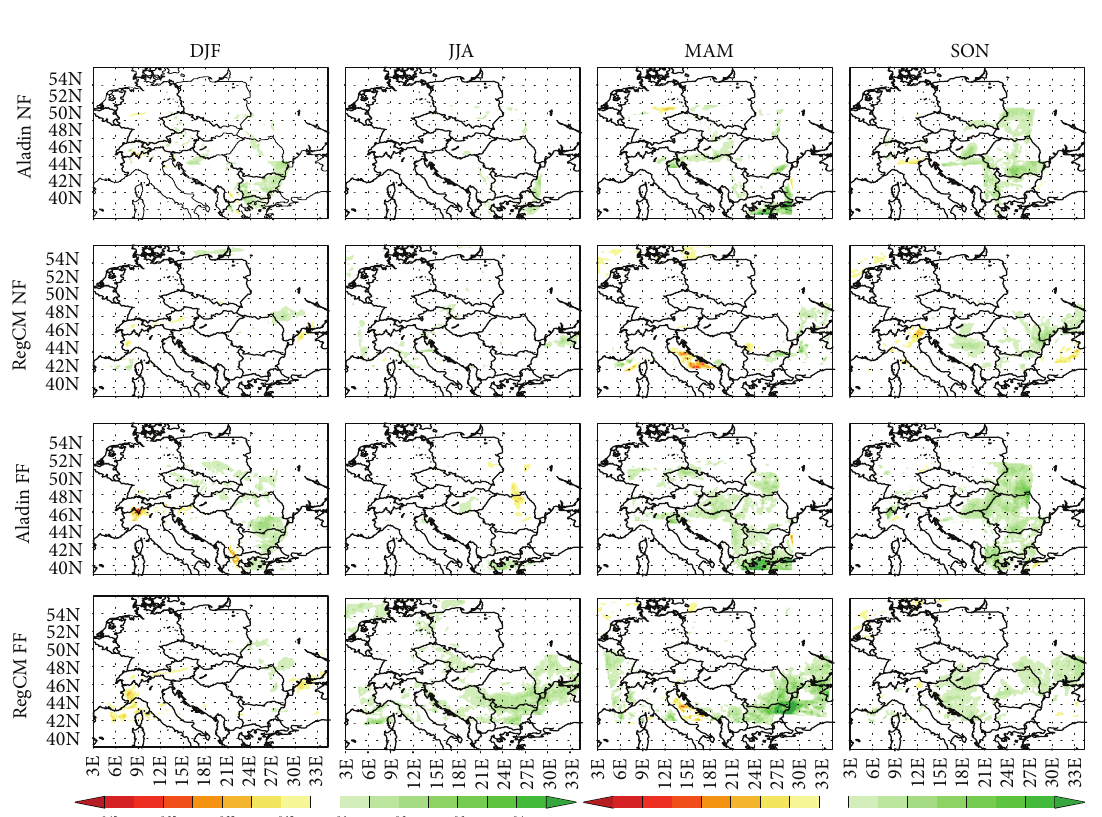
Figure 15: Change in precipitation interannual coefficient of variation. Units are